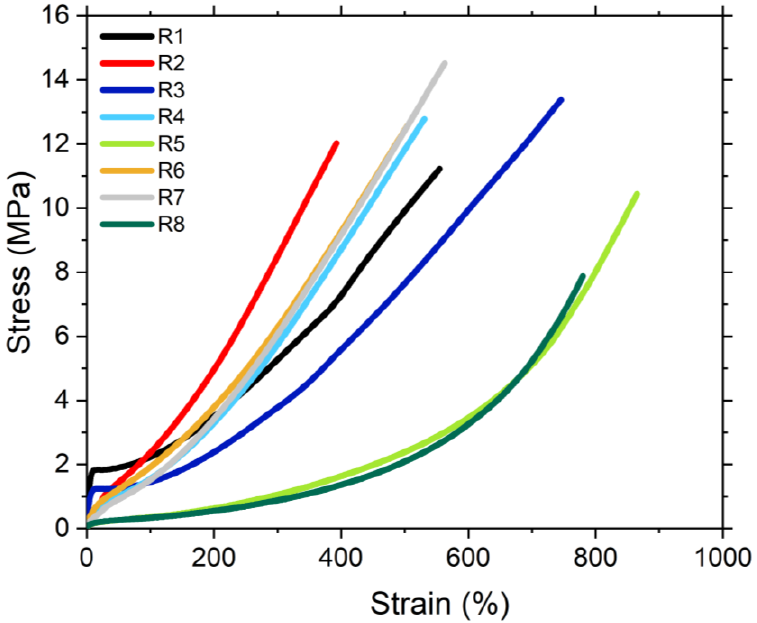
Figure 9. Stress-strain curves of the studied compounds.